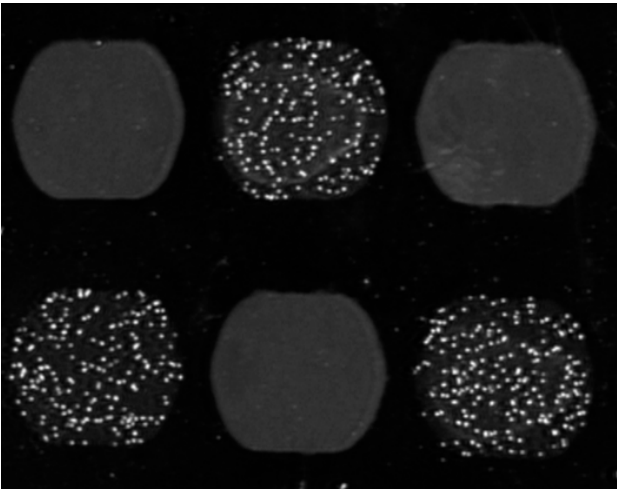
Figure 1. Principles of cellular SPR. ( A ) For nonadherent and rigid cells such as RBC and ( B ) for adherent cells. Generally, mammalian cells sediment and penetrate into the evanescent field and will be detected. The cell surface antigens will bind to specific ligands on the surface and will deform the cell. The signal depends on anchoring points of ligands with the cell. More anchoring points of ligand–cell surface antigens interactions allow that the cell penetrates deeper in the hydrogel of the sensor surface giving rise to higher SPR signals. Flow induces a force to cells and effectively deforms the cell and a larger part of the cell will be detected. This is reversible for rigid cells such as RBC in ( A ), but can lead to spreading in time and during exposure of the cells, a continuously increasing SPR signal occurs in ( B ) [30].